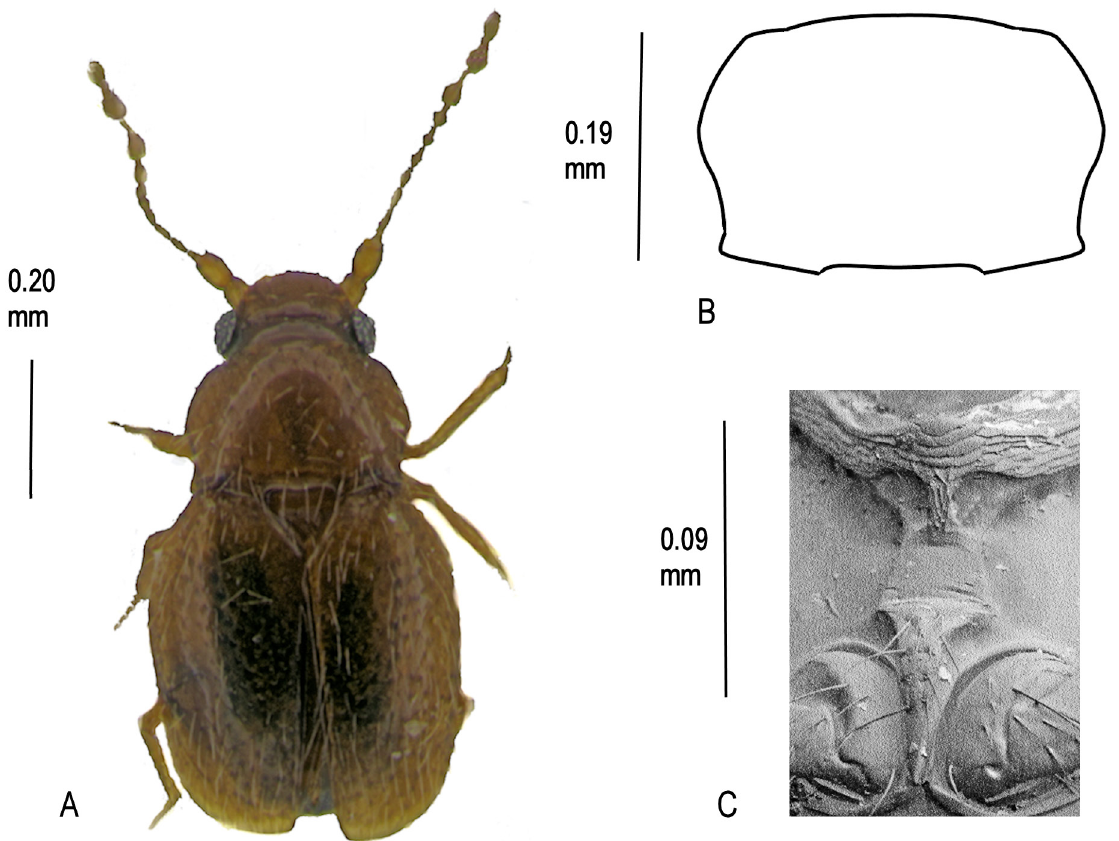
Fig. 78 . Cissidium petri Darby, 2015. A . Habitus. B . Pronotum. C . Mesoventrite showing median process of collar, mid-keel and keel, ×